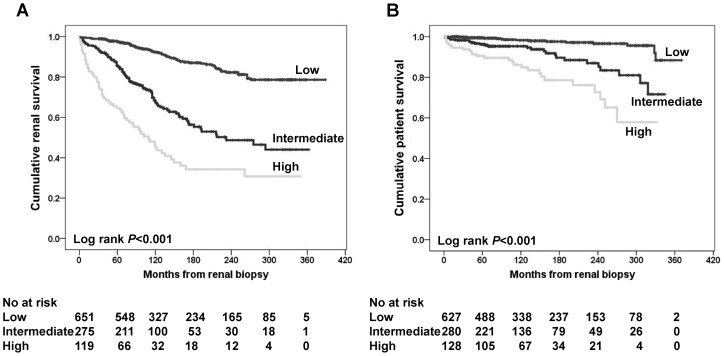
Cumulative renal(A) and patient survival (B) according to the risk stratification. The primary outcome is patient survival. The numbers of patients remaining at 60, 120, 180, 240, 300, and 360 months of follow-up are shown at the bottom.